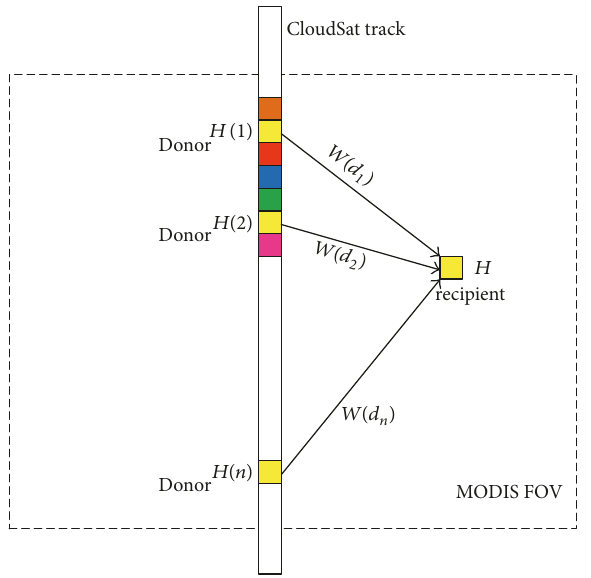
Figure 5: Conceptual rendering of CloudSat/CALIPSO ground tracks nested within the MODIS swath. Arrows map CBH type- constrained donor points (colors denote different cloud types) along the active sensor track to the MODIS recipient